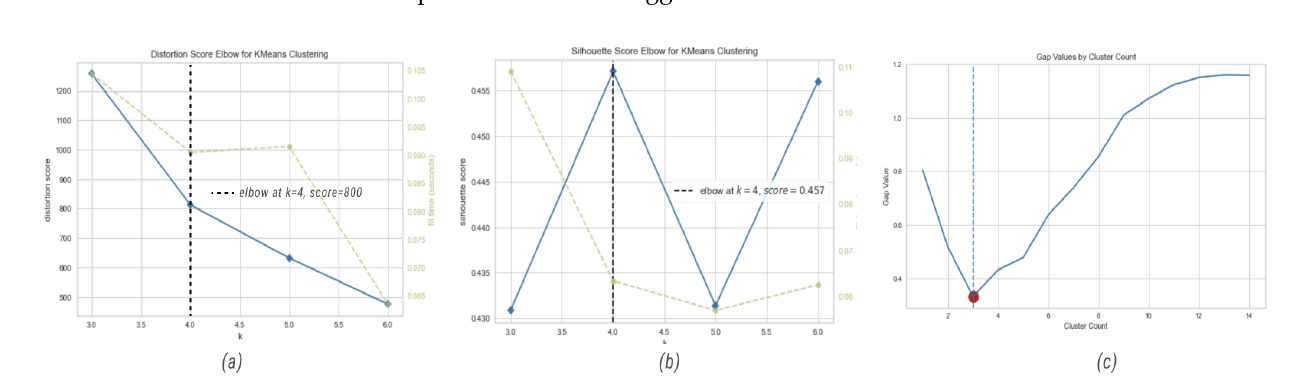
Figure 16. The result of the ( a ) elbow, ( b ) silhouette, and ( c ) gap statistic methods.